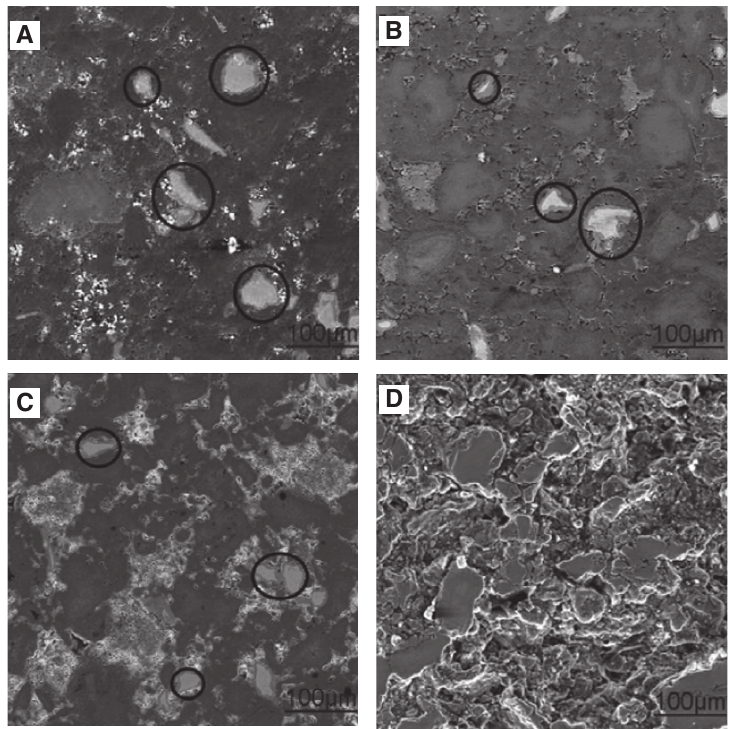
Figure 5 Microstructure of self-lubricating materials with different CB addition amounts: (A) 5%, (B) 10%, (C) 15%, and (D)